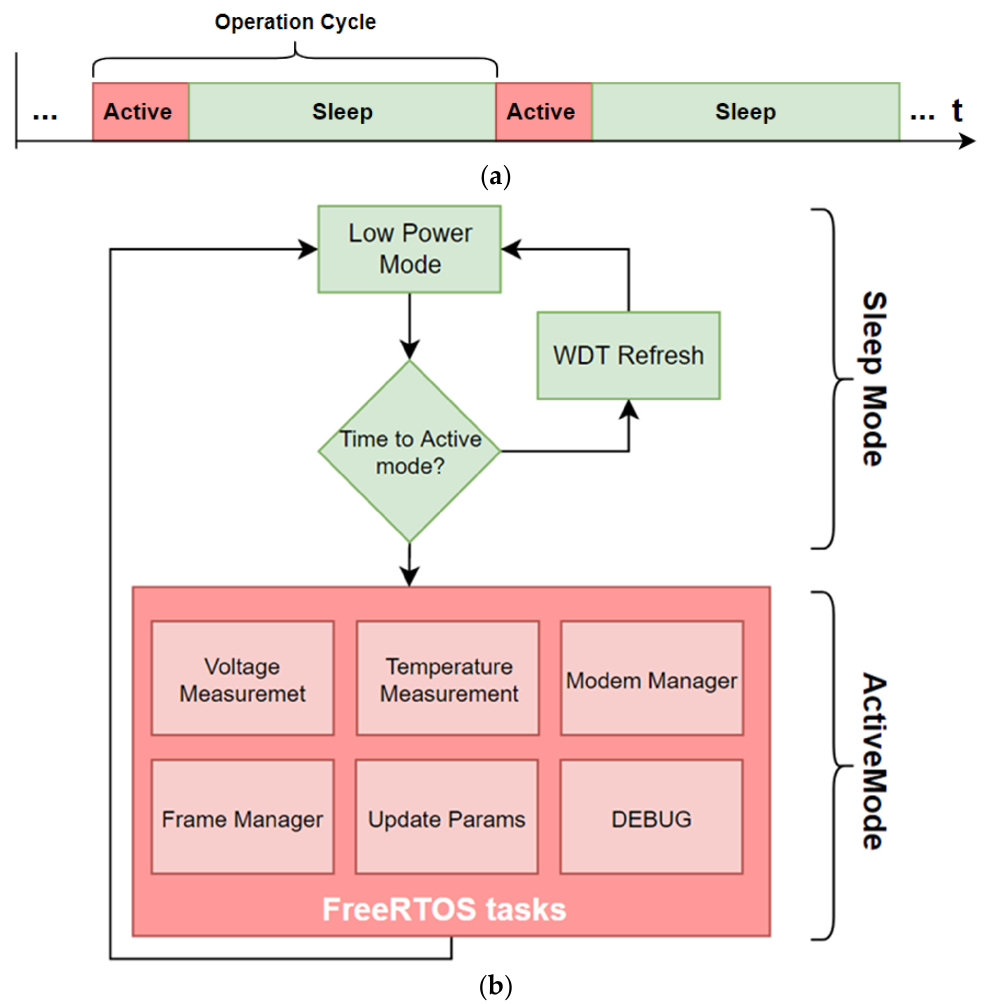
Figure 5. ( a ) Operation cycle scheme. ( b ) Time flow diagram.